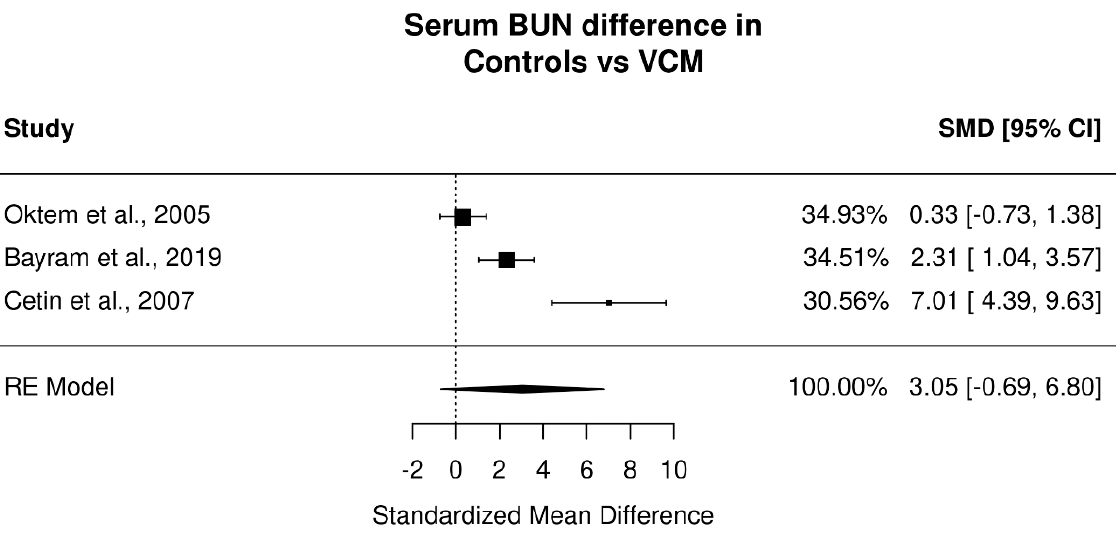
Figure 3. Effect of vancomycin on serum blood urea nitrogen in animals receiving vancomycin vs. controls. Presented in plots Standardized Mean Difference and 95% confidence intervals [25,32,34]. Table 2. Summary of meta-analysis results.